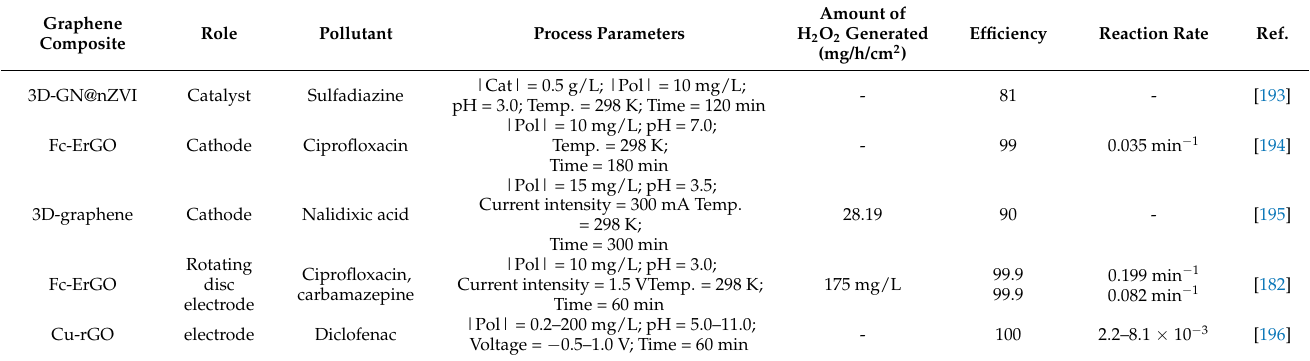
Table 4. Fenton processes based on graphene composites for degradation of